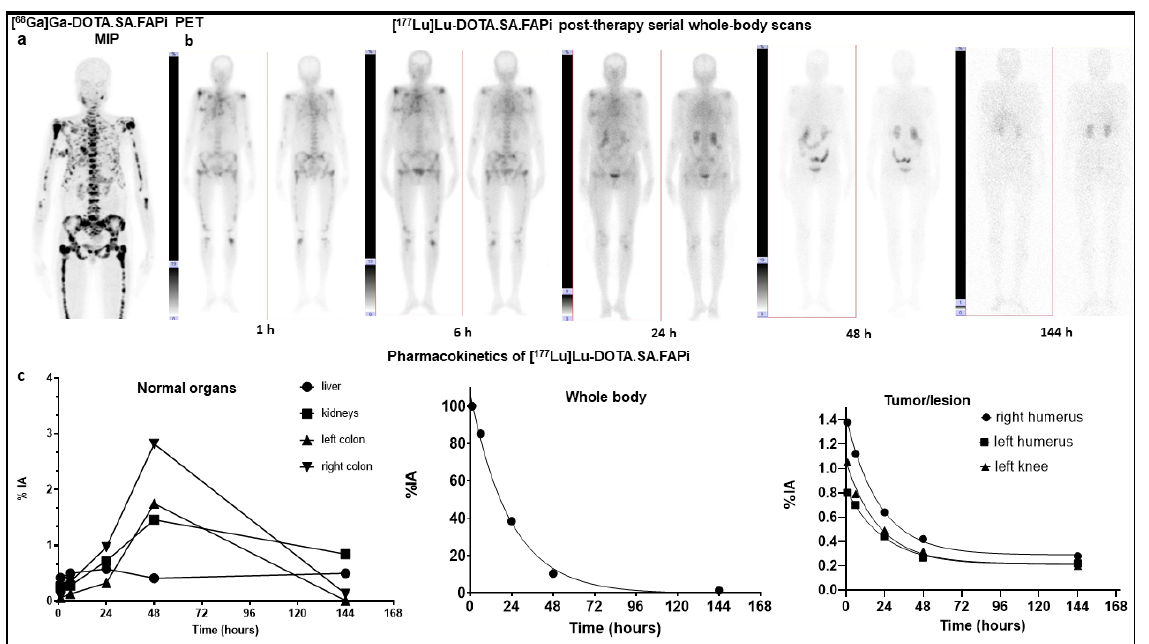
Figure 2. ( a ). [ 68 Ga]Ga-DOTA.SA.FAPi PET/CT images of a 49-year-old woman with breast cancer shows biodistribution in the oral mucosa, pancreas, and kidneys and intense expression of DOTA.SA.FAPi in extensive skeletal metastases. B Serial [ 177 Lu]Lu-DOTA.SA.FAPi whole body scintigraphy images for dosimetry, after intravenous injection of 1.85 GBq of radiotracer, demonstrates normal and minimal biodistribution in the oral mucosa, salivary glands, liver, kidneys, and intestines. ( b ). Accumulation in the metastatic sites were observed at 1 and 6 h p.i. and decreased significantly by 24 h p.i., with nearly complete washout by 48 h p.i. ( c ). Time–activity curves for whole body and organs that were easily discernible and metastatic sites generated from region of interest placed on whole-body scintigraphy images.